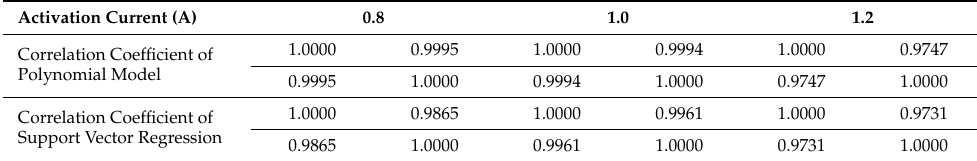
Table 5. Correlation Coefficient between observed and predicted stiffness at different